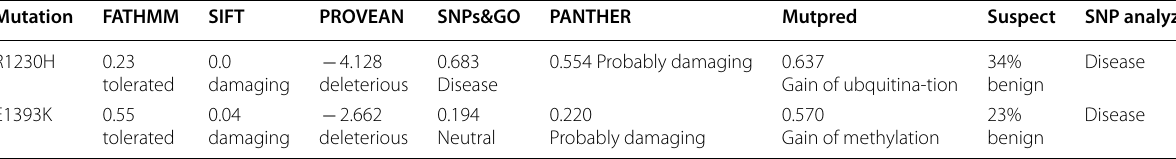
Table 8 Prediction of nsSNP deleteriousness by another different ranking